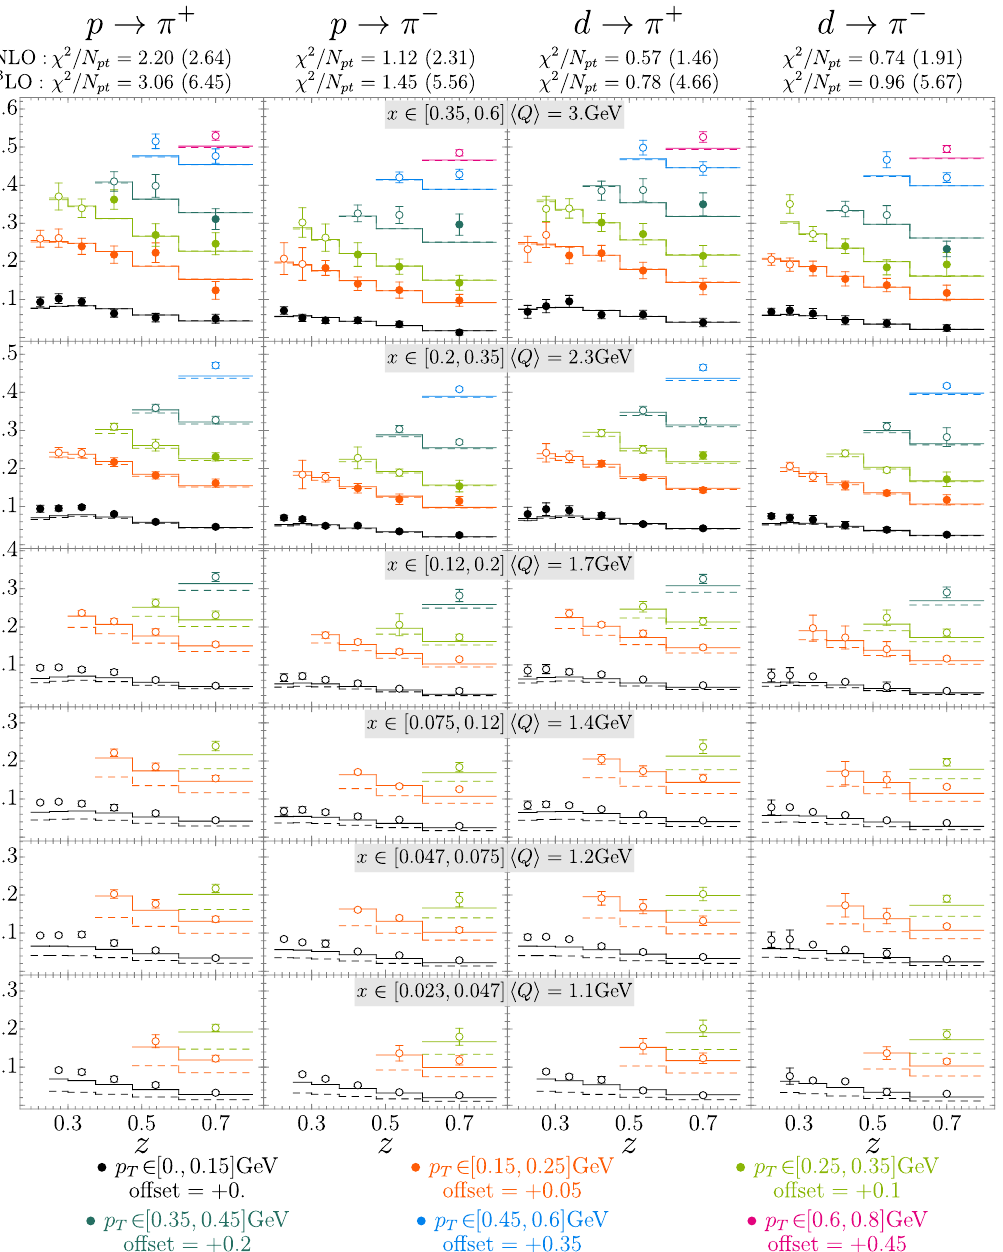
Figure 17 . Unpolarized SIDIS multiplicities (4.4) (multiplied by z 2 ) for production of pions o(cid:11) proton/deuteron measured by HERMES in di(cid:11)erent bins of x , z and p T . Solid (dashed) lines show the theory prediction at NNLO (N 3 LO). Filled (empty) point were (not) included in the (cid:12)t of NP parameters. On the top of the table the value of (cid:31) 2 =N pt for each channel is presented, the value in brackets being the (cid:31) 2 =N pt for shown set of the data (empty and (cid:12)lled points together). For clarity each p T bin is shifted by an o(cid:11)set indicated in the legend.